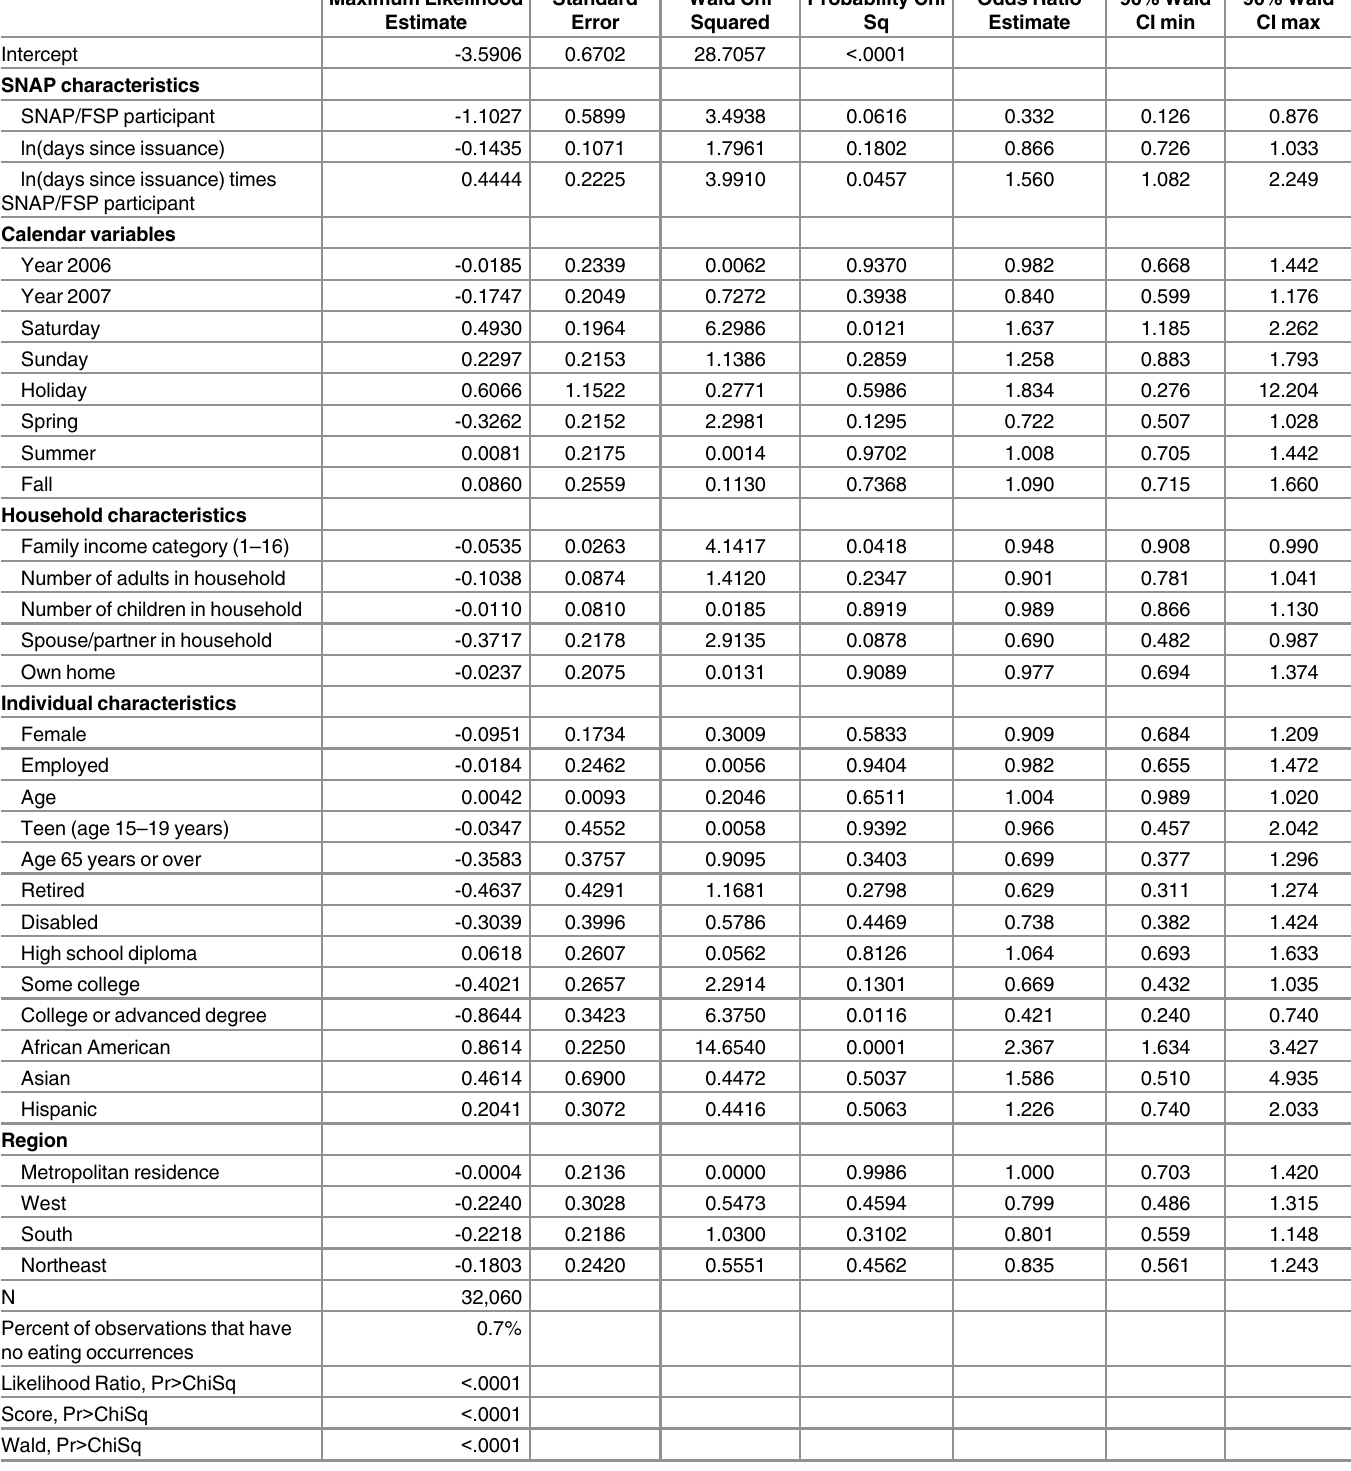
Table 2. Logit model of the probability of not eating over an average day, 2006 –